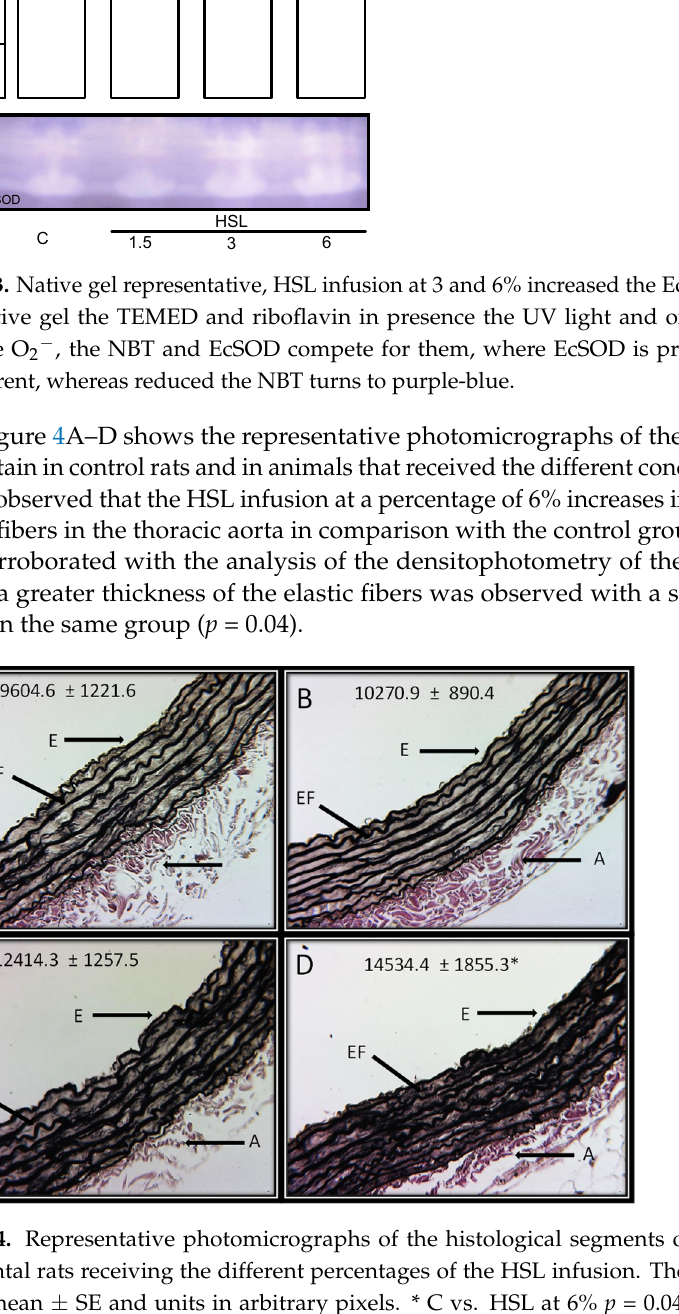
Figure 2. Linear regression between SBP vs. TAC panel ( A ) and IL-10 vs. TAC panel ( B ) Constant Variance Test Spearman Rank Correlation.